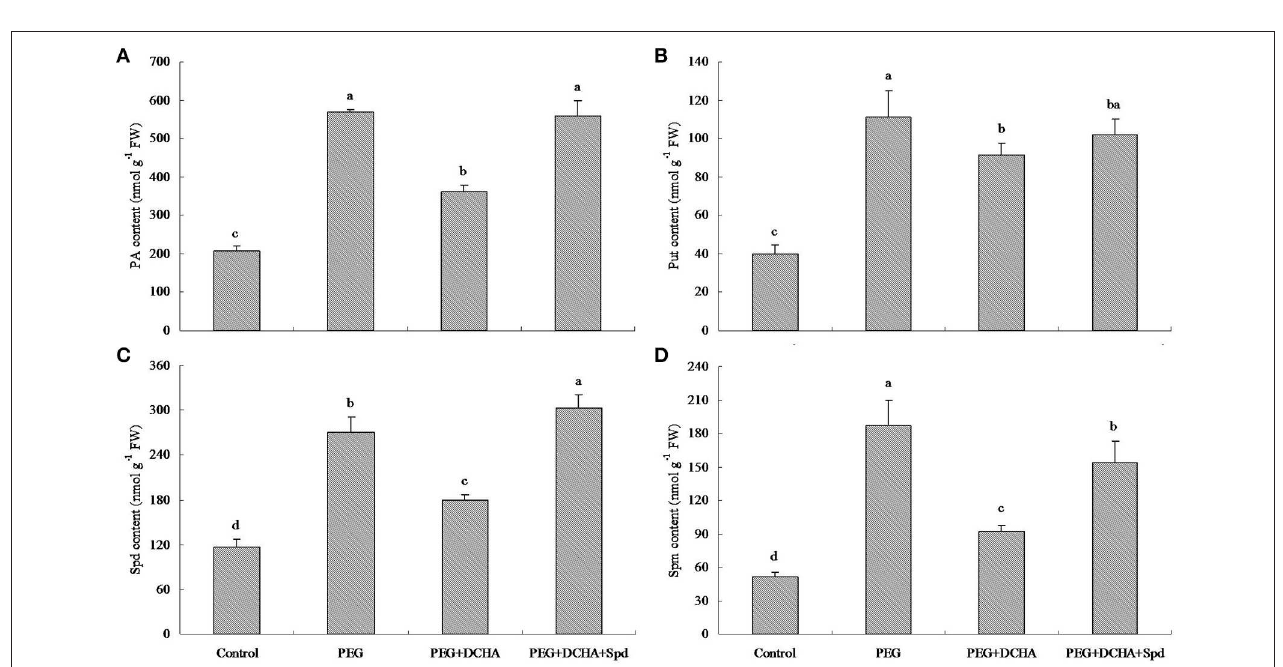
FIGURE 2 | Time course of PEG 6000-induced polyamine (PA) (A), putrescine (Put) (B), spermidine (Spd) (C), and spermine (Spm) accumulation (D) in leaves. The detached leaves were pre-treated with distilled water for 1h to eliminate wound stress and then exposed to distilled water (control) or 15% PEG solution for 12h. Means of four independent samples are presented. Bars represent standard error. “ * ” indicate LSD values where significant differences were detected ( P < 0.05) between two treatments at a given time.